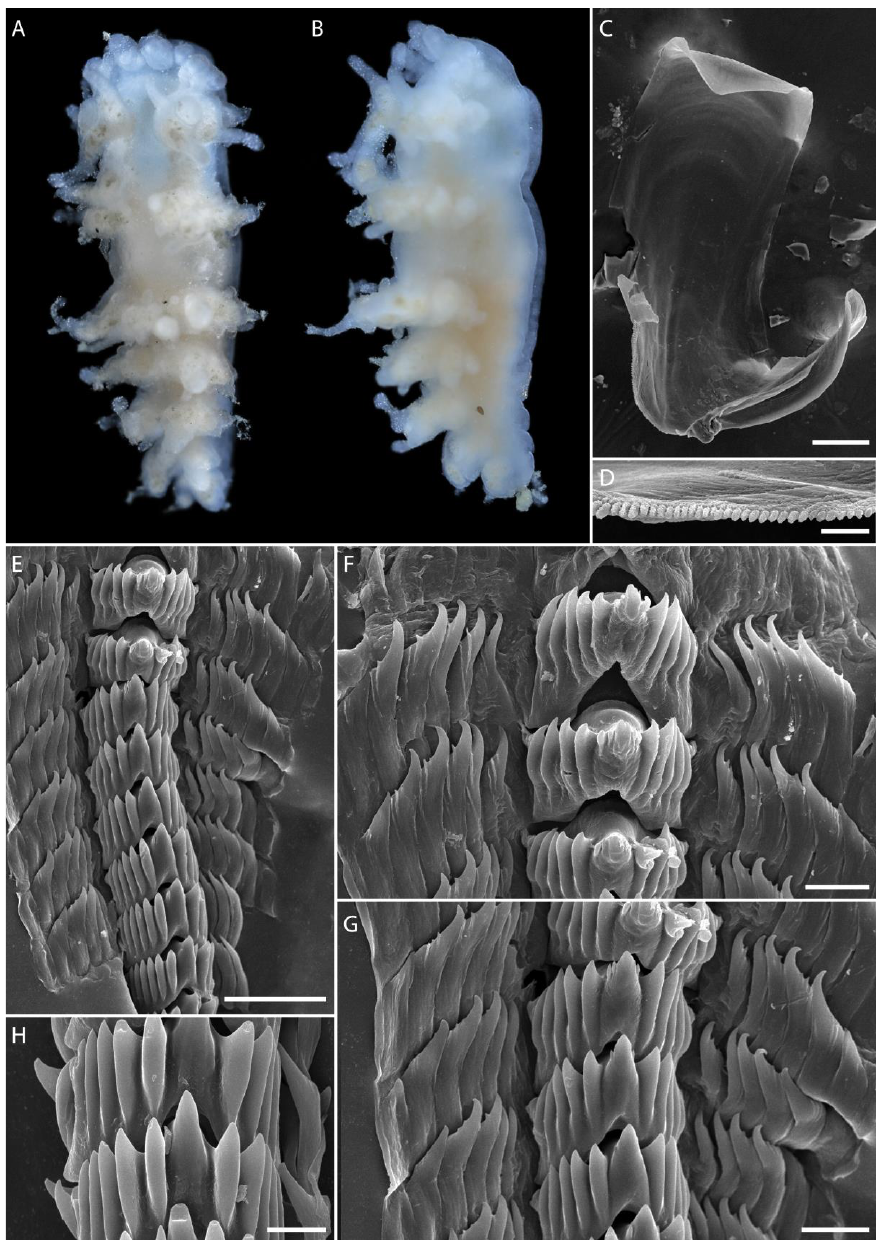
Figure 8. Dendronotus sp. 1, features of external and internal morphology (SEM), MIMB44624. ( A , B ) — living specimen, dorsal view ( A ) and lateral view from the right ( B ). ( C ) — left jaw plate. ( D ) — masticatory process of the jaw. ( E ) — middle radular portion. ( F ) — rachidian and lateral teeth. ( G ) — rachidian tooth. ( H ) — rachidian teeth, anterior radular portion. ( I ) — lateral teeth. Scale bars: ( C ) = 100 µ m; ( D ), ( F , G ) = 20 µ m; ( E ) = 50 µ m; ( H ) = 10 µ m. Distribution : Known only from the Kuril